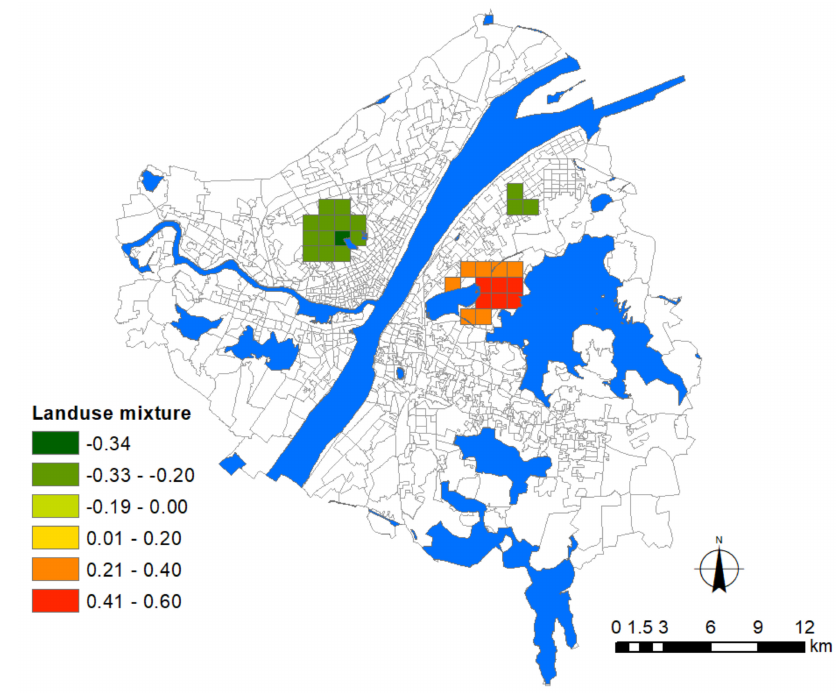
Figure 12. Areas significantly a ff ected by the landuse mixture. The legend denotes the corresponding intensity of